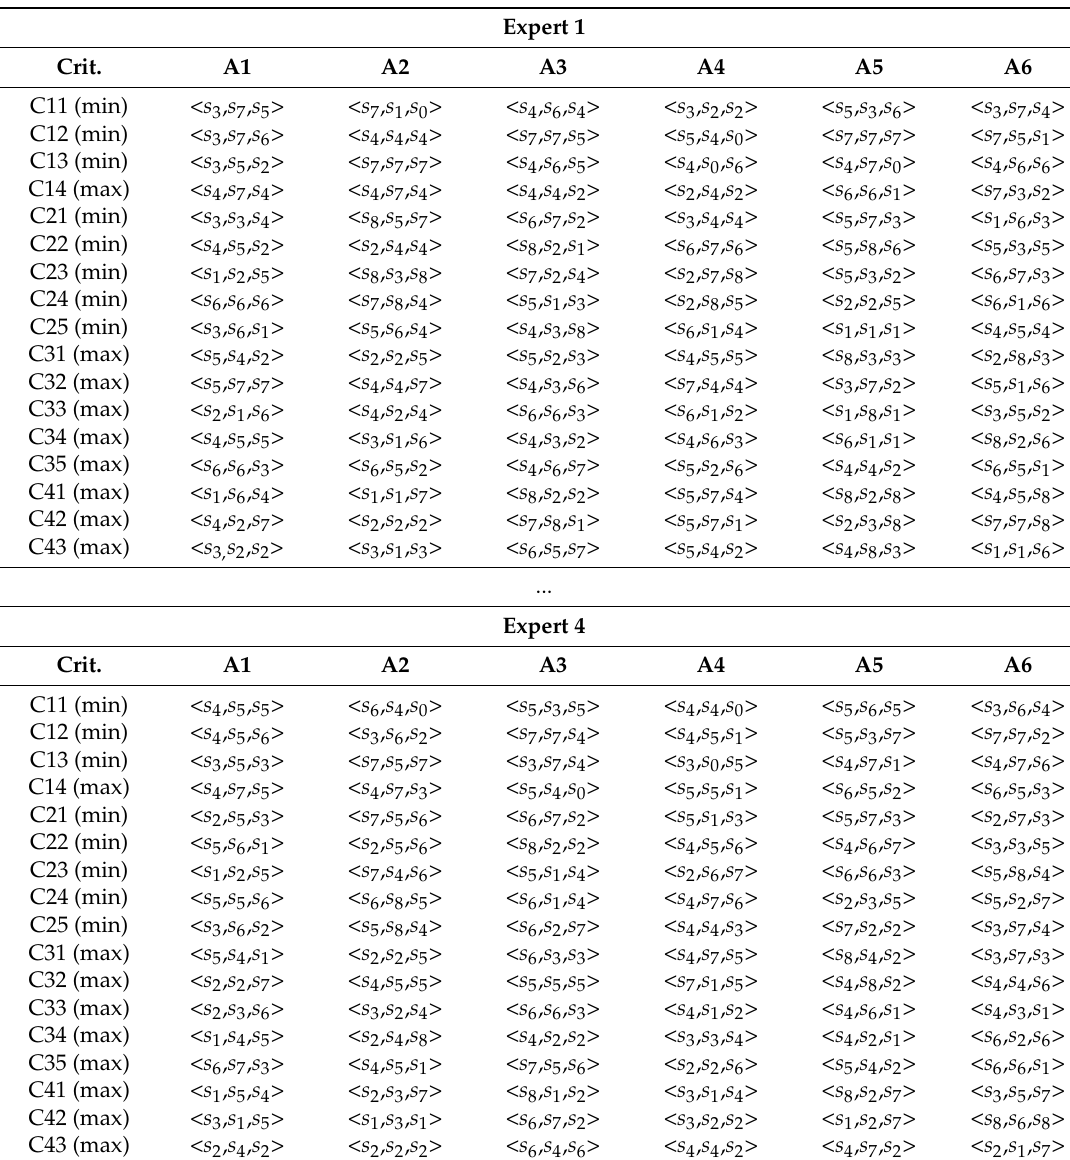
Table 5. Expert correspondence